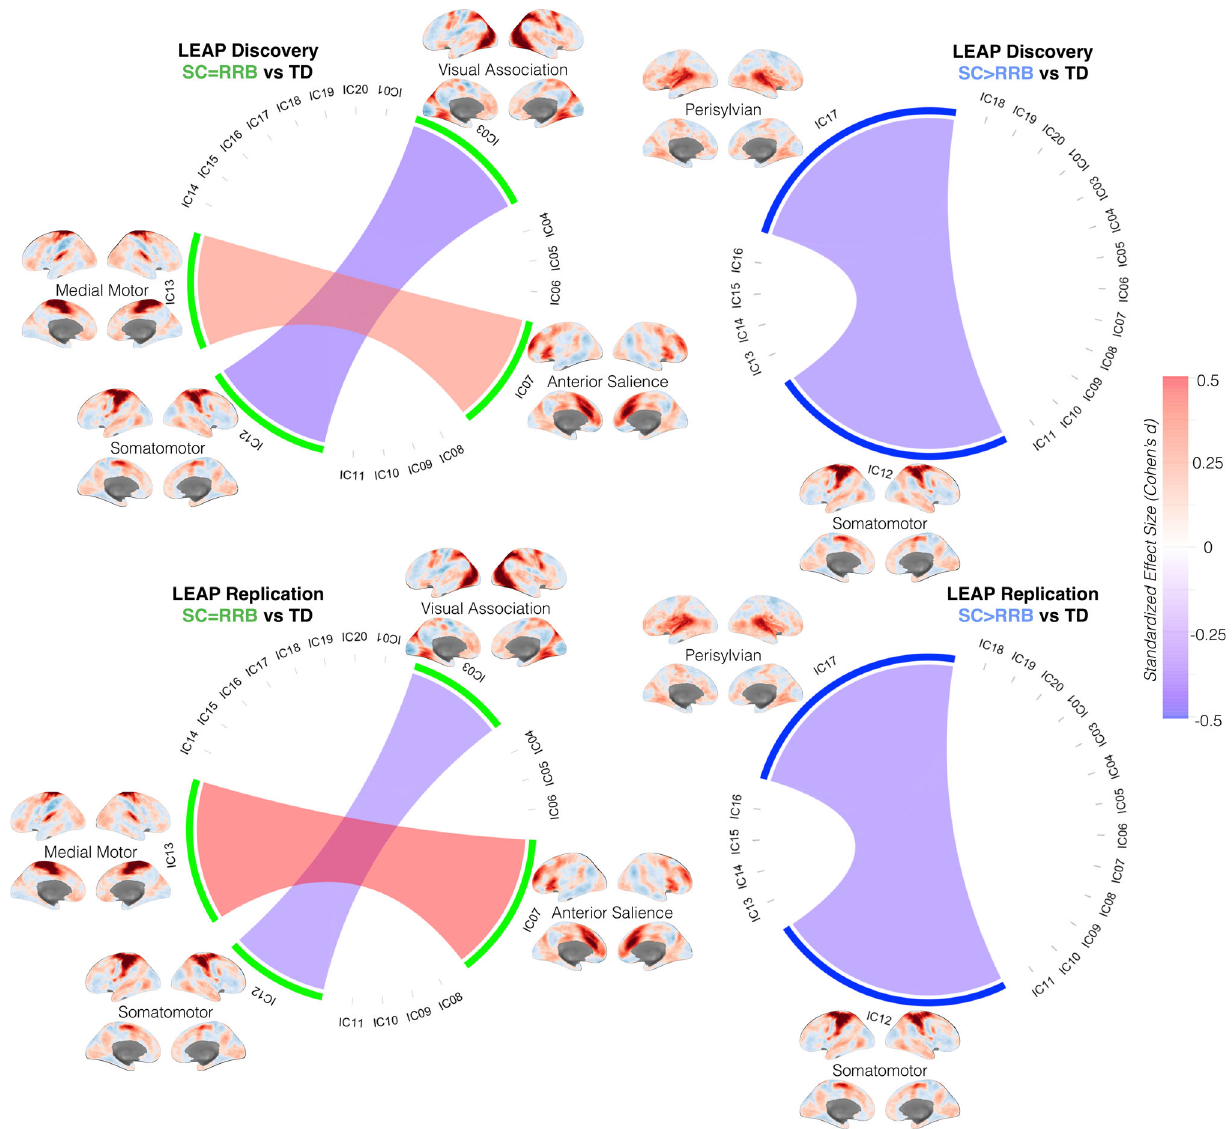
Fig. 3 Replicable subtype differences in functional connectivity. This fi gure shows chord diagrams of replicable functional connectivity differences between SC = RRB vs TD (left) or SC > RRB vs TD (right) when subtypes are de fi ned at a z-threshold of 1. However, edges shown in these diagrams are consensus edges that appear in every analysis of connectivity differences irrespective of the z-threshold used to de fi ne the subtypes. Red edges indicate hyperconnectivity in the autism subtype relative to TD, while blue edges indicate hypoconnectivity in the autism subtype relative to TD. The intensity of edge color indicates standardized effect size (Cohen ’ s d) shown on the color bar on the right. The cortical surface renderings of each component are unthresholded z-stat maps. Areas with higher z-stats (dark red) are of primary importance for the IC map. The top row shows effects in the EU-AIMS LEAP Discovery set, while the bottom row shows effects in the EU-AIMS LEAP Replication